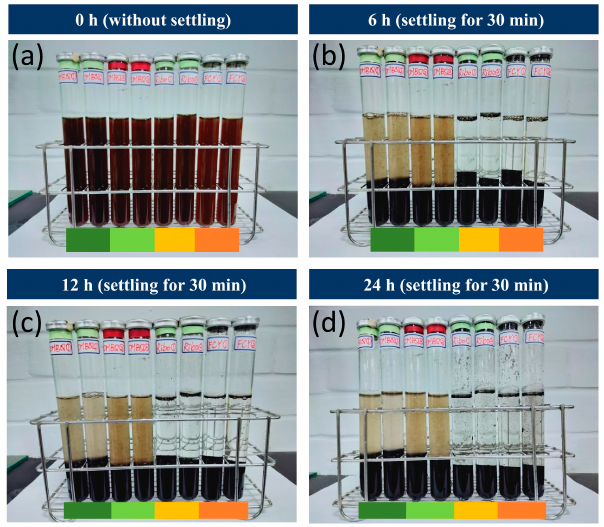
Figure 9. Images photographed under a quiescent condition after different reaction times: ( a ) 0 h; ( b ) 6 h; ( c ) 12 h; and ( d ) 24 h. At 0 h, the image was taken after mixing all the ingredients without settling; at 6, 12, and 24 h, the images were taken with 30 min of settling. The initial concentration of GO was consistently controlled at 1.0 mg mL − 1 . The Hungate tubes of all conditions were prepared as duplicates adding different concentrations of mediators, and were labeled using different colors. From left to right: dark green: 0.2 mM DMoBQ; light green: 0.2 mM DMBQ; yellow: 5 µ M riboflavin; orange: 2.5 mM